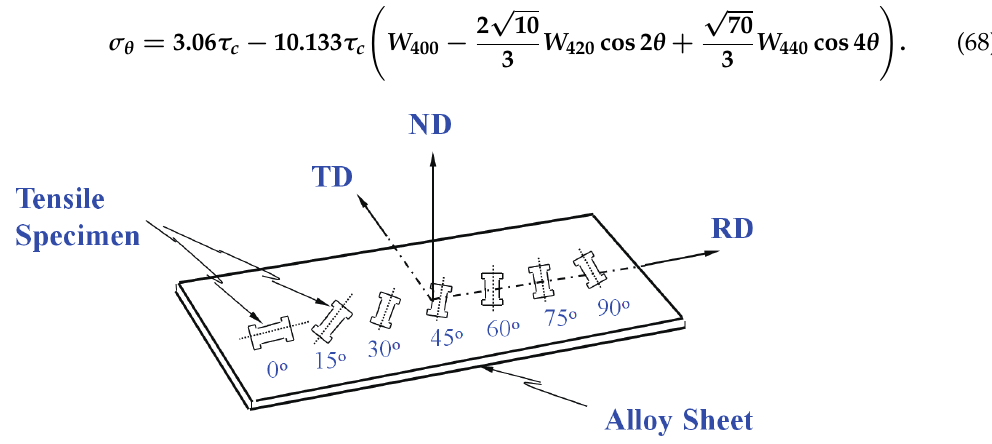
Figure 1. Samples S θ of metal